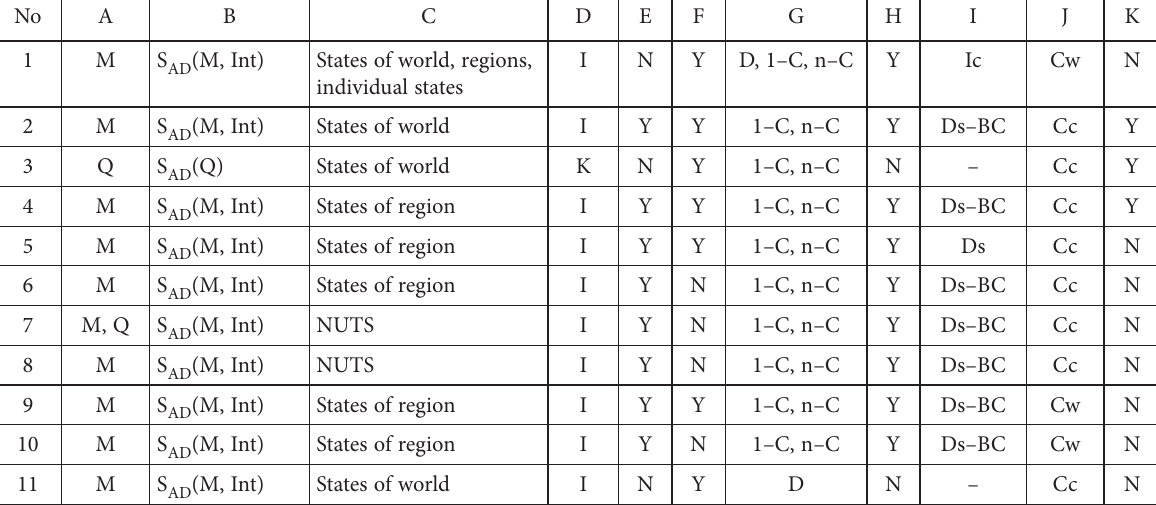
Table 2. Mutual comparison of the analysed WMAs from the viewpoint of theory of map representation